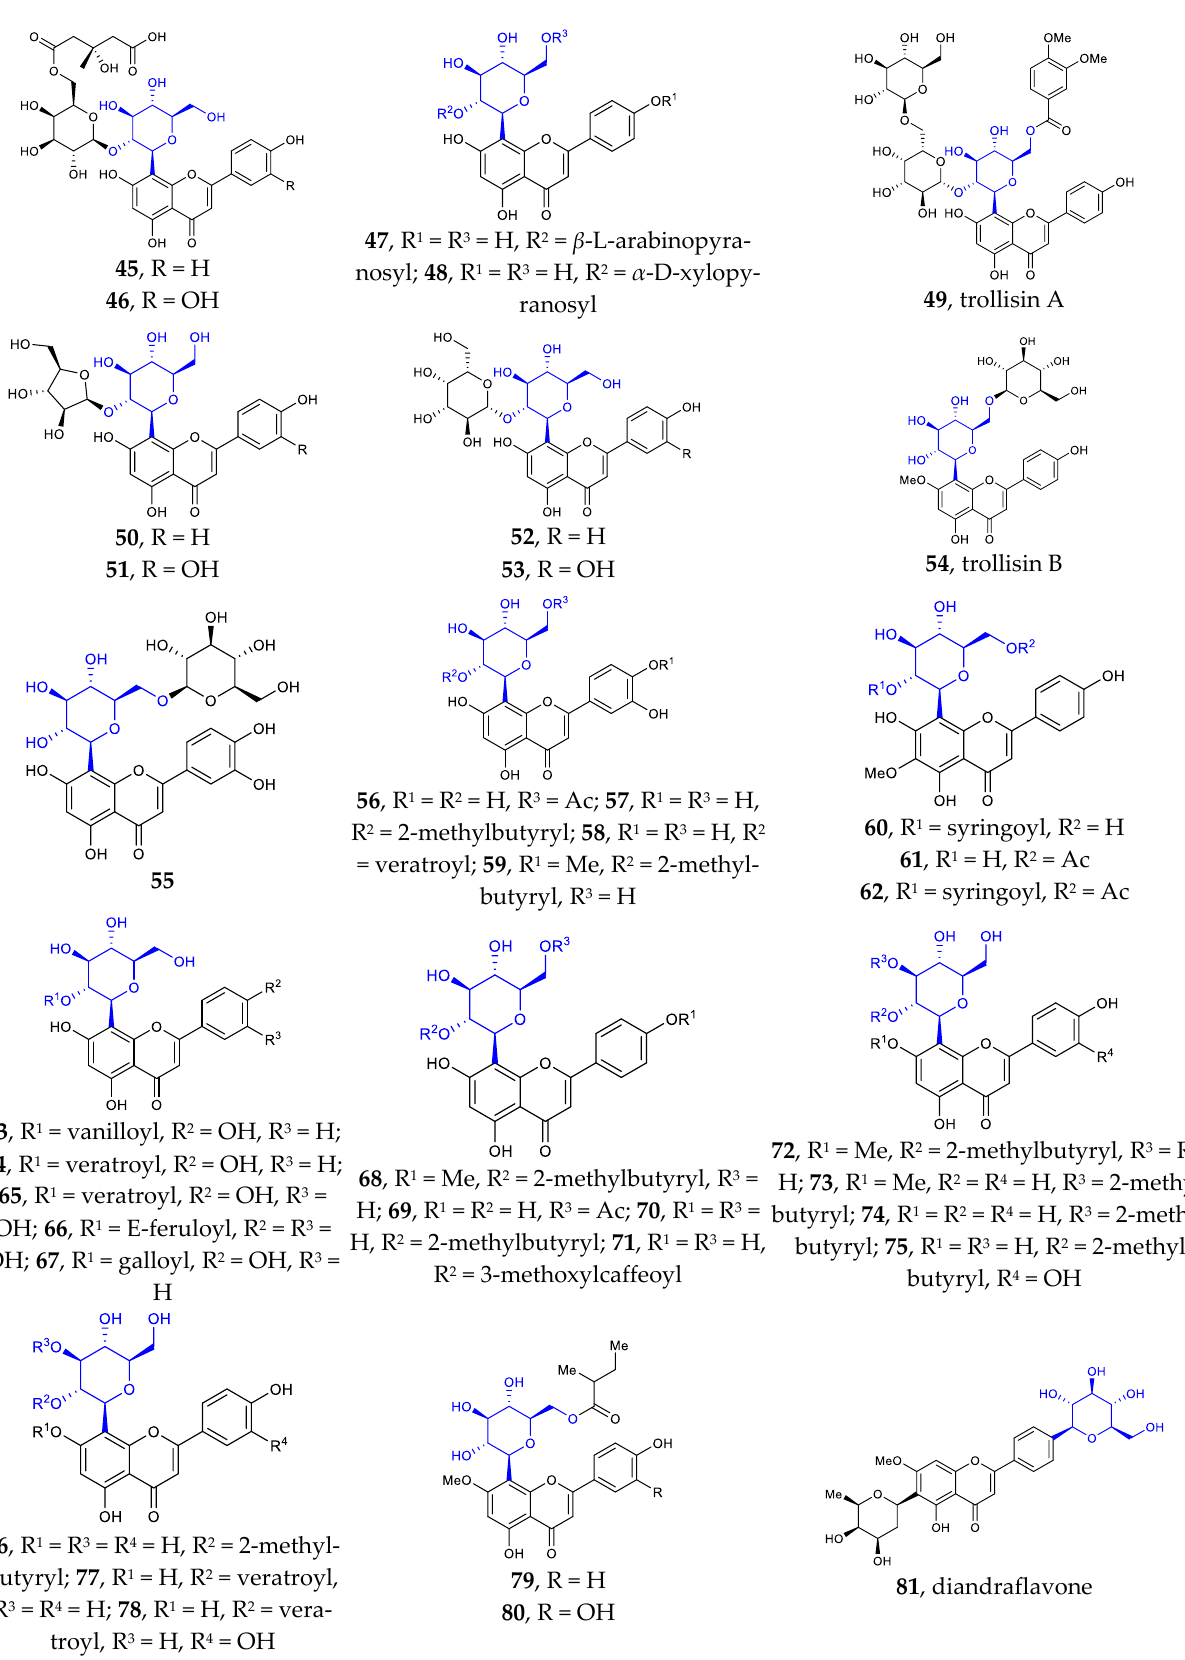
Figure 1. Chemical structures of flavonoid 6- or 8- C - β -D-glucopyranosides ( 1 - 80 ) and flavonoid 4 (cid:48) - C - β -D-glucopyranoside ( 81